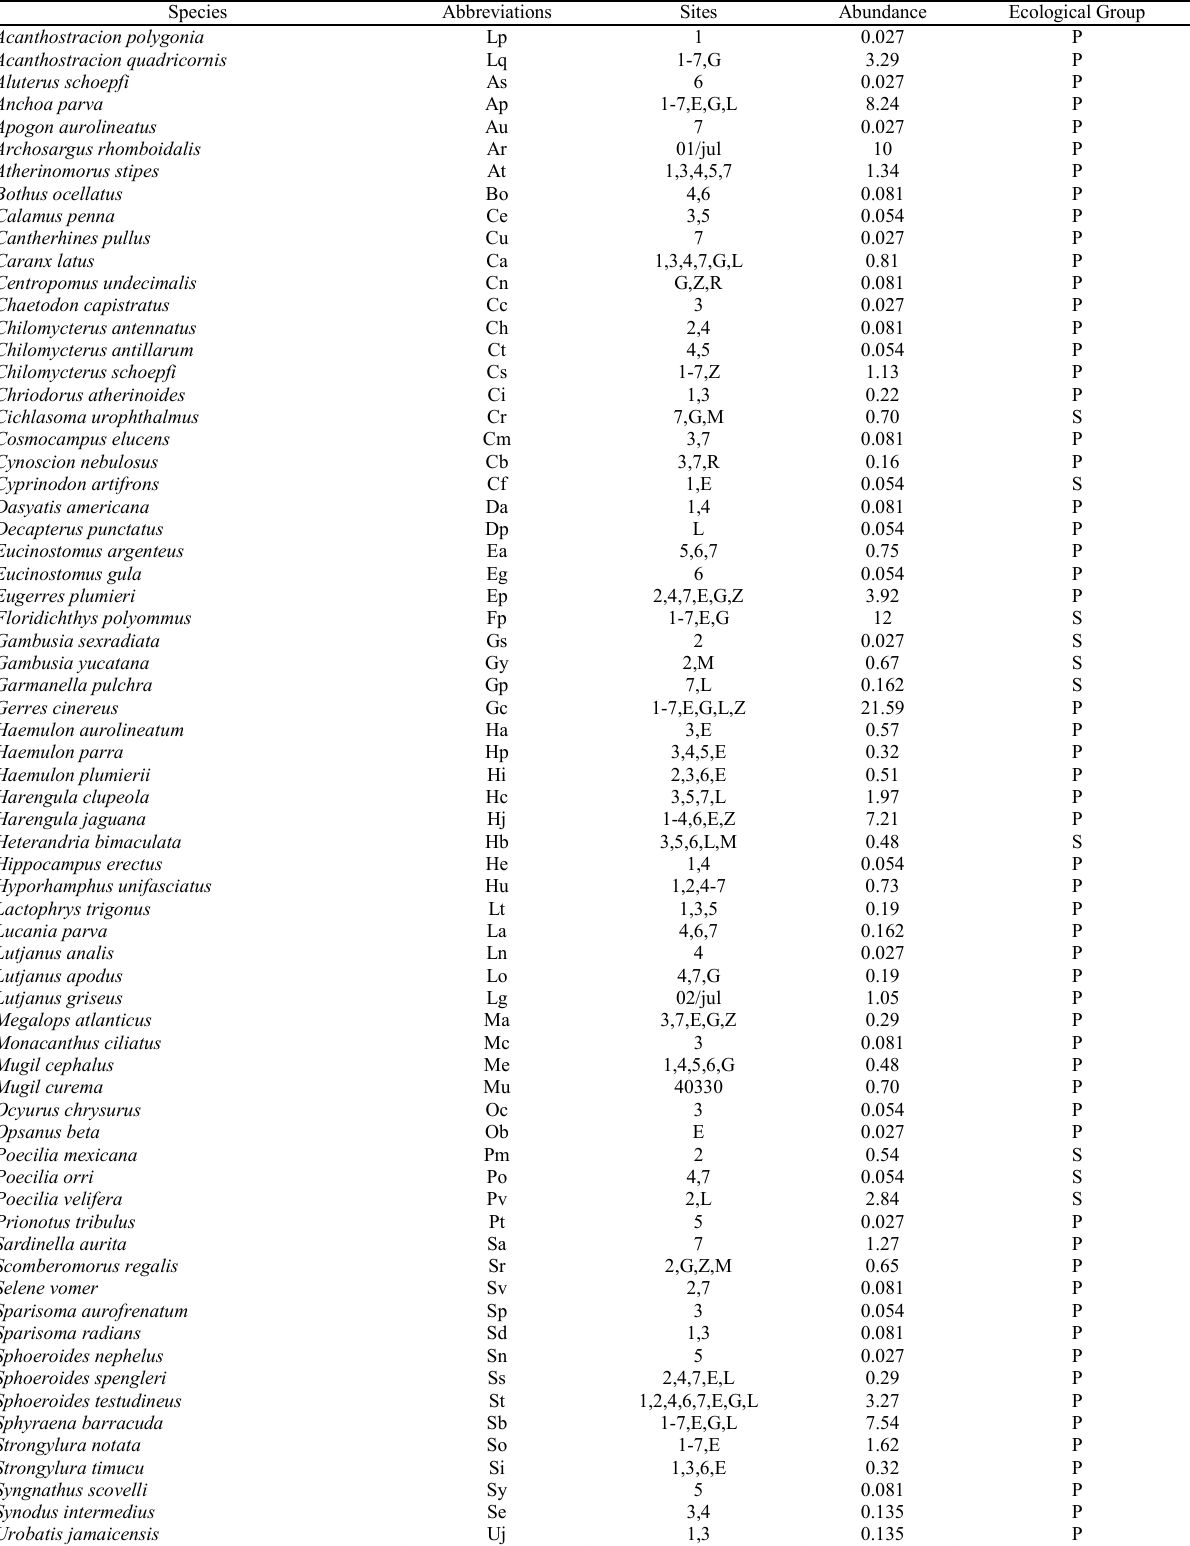
Table 1. Fish species, abbreviations of the species, collection sites, abundance (%) and ecological group (P: primary; strictly freshwater, S: secondary; brackish water species and P: peripheral; high-salinity species, usually marine affinity) in Chacmochuch Lagoon System. Sites 1, 2, 3, 4, 5, 6 and 7 are of Chacmochuch bay; E=Laguna Esperanza, G=Laguna Garzas, L=Laguna Larga, Z=Laguna Zapatito, R=Ría Nagigo and M=Laguna Manatí. Fish species order is according to their abundance